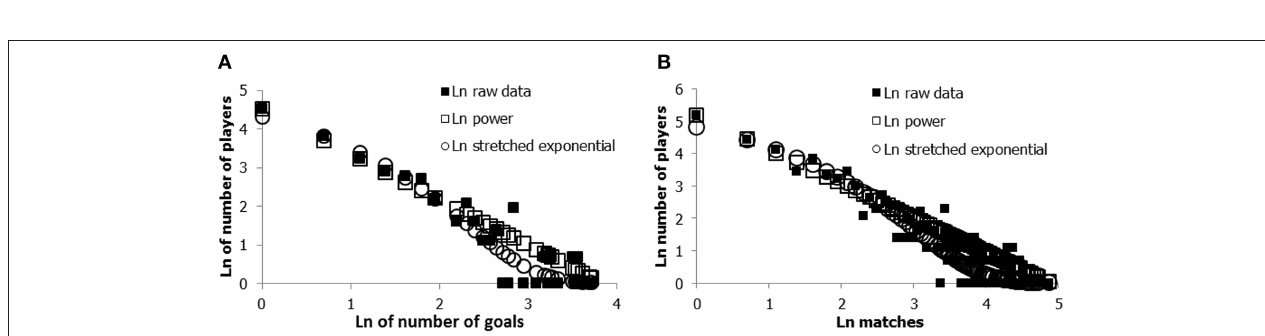
FIGURE 1 | Distributions of the number of goals made during international matches of the Dutch soccer team against the number of players scoring the corresponding number of goals (A), and the number of international matches a soccer player played in the Dutch national team (B).